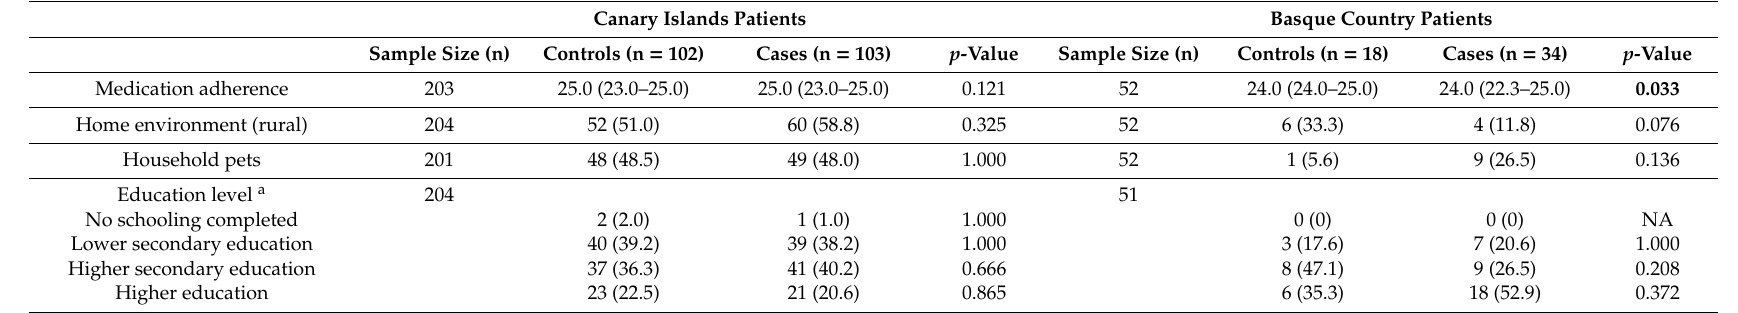
Table 3. Description of patients with asthma recruited in the GEMAS